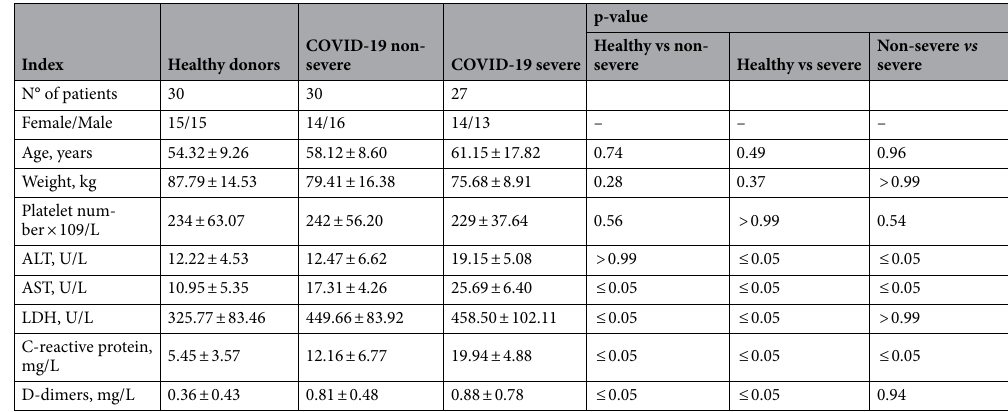
Table 1. Patients’ data is presented as mean standard deviation. ALT stands for alanine aminotransferase; AST stands for aspartate aminotransferase; and LDH stands for lactate dehydrogenase. Unpaired statistical analysis P values were calculated using the student t-test. Statistical significance is defined as p less than 0.05.